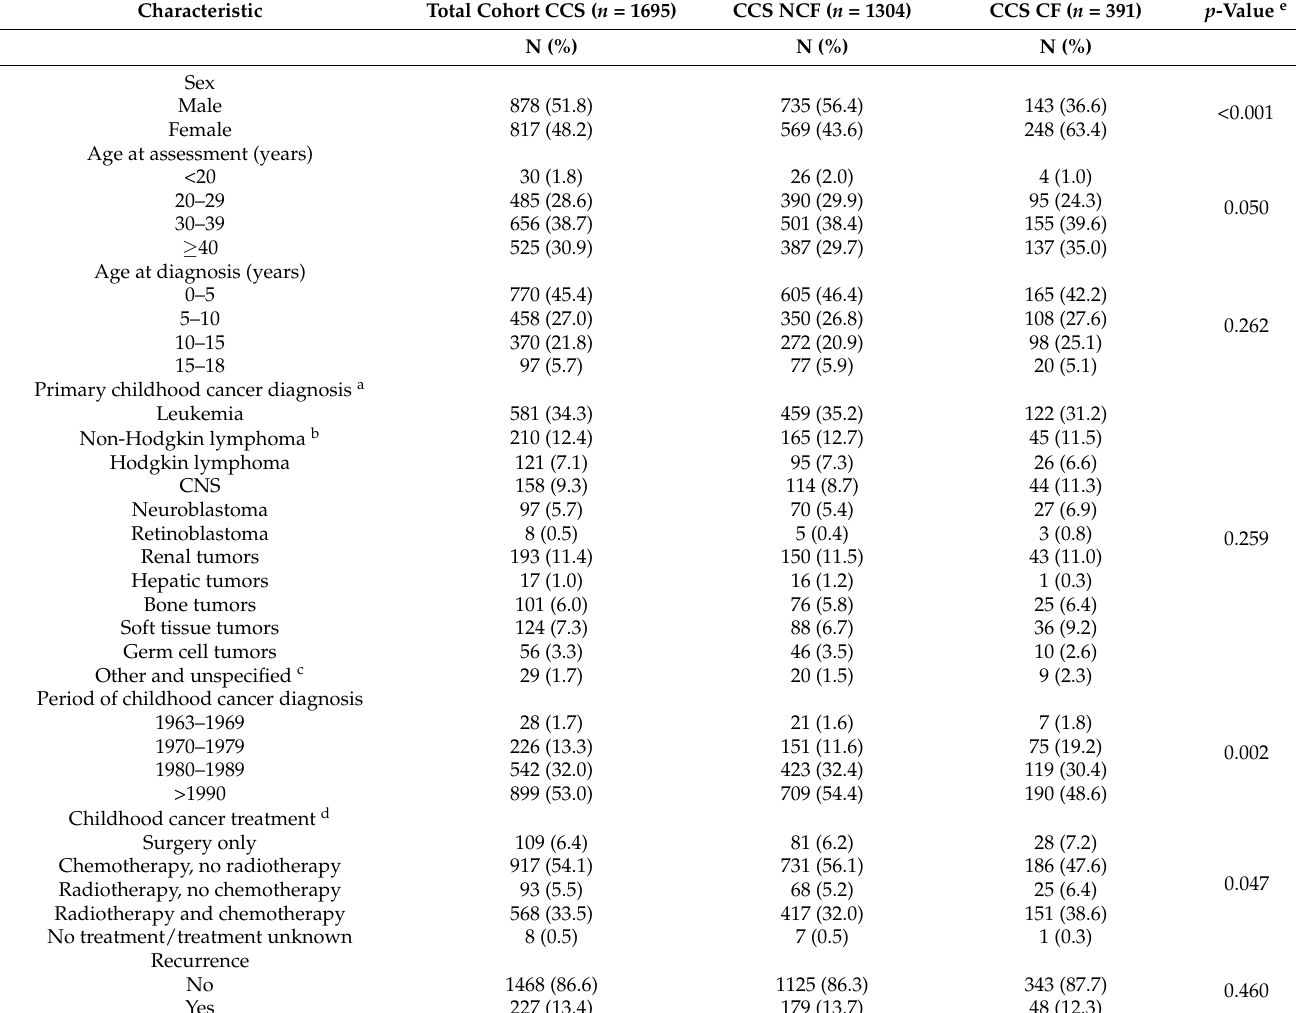
Table 1. Participant Characteristics for total cohort and by chronic fatigue